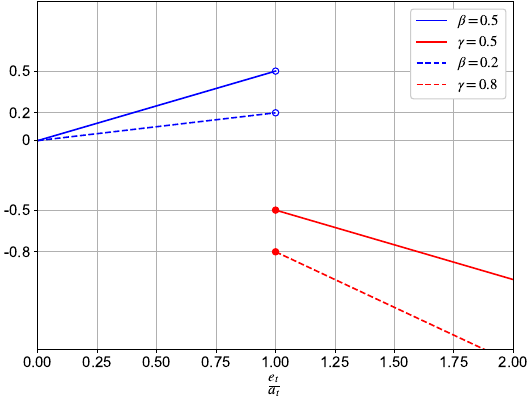
Figure 9. Reward function of the proposed DRL-DT with different β and γ . For the training process of the DRL